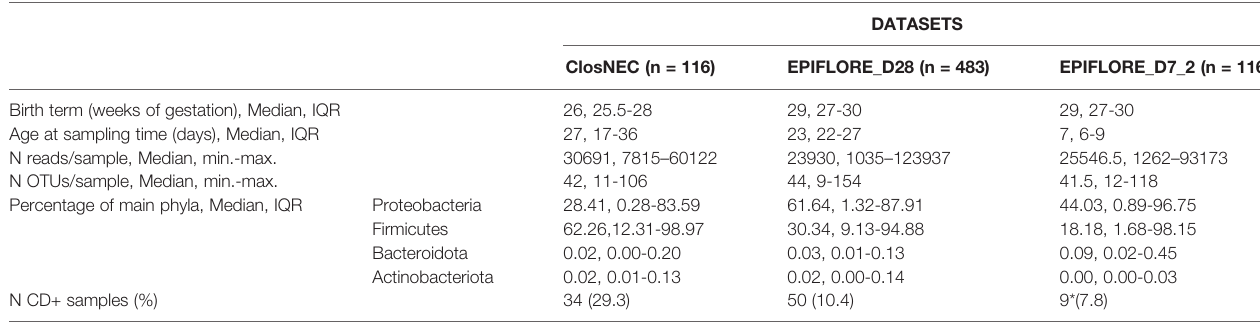
TABLE 1 | Characteristics of datasets and results of the NGS analysis of the intestinal